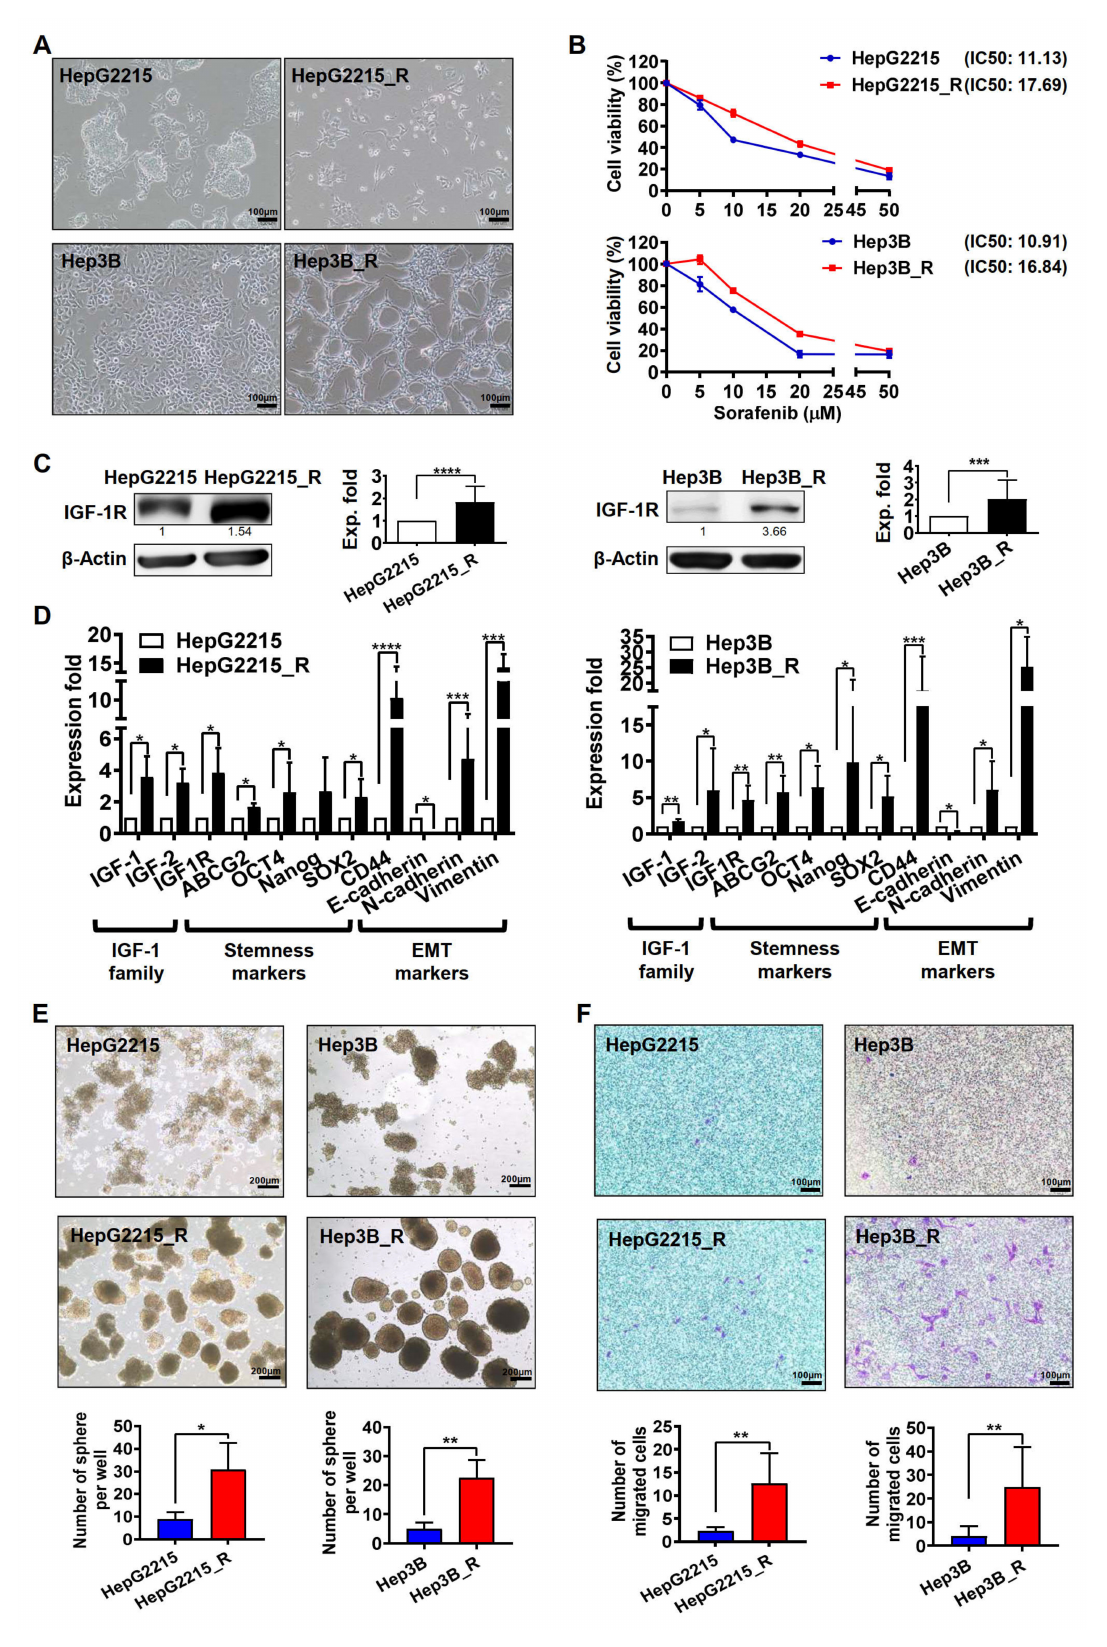
Figure 1. High IGF-1R expression and malignant properties in sorafenib-resistant HCC cell lines. ( A ) Cell morphology of sorafenib-naïve HCC cells (HepG2215 and Hep3B) and sorafenib-resistant HCC cells (HepG2215_R and Hep3B_R). ( B ) Cell viability and IC50 values of sorafenib-naïve